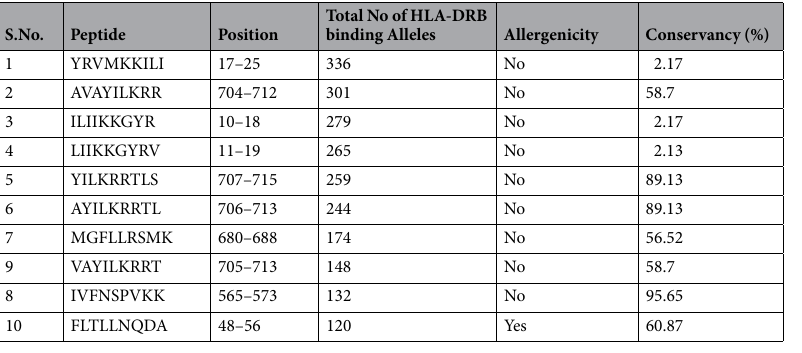
Table 6. Top 10 HTL epitope with their allergencity and conservancy, selected on the basis of maximum number of HLA-DR binding